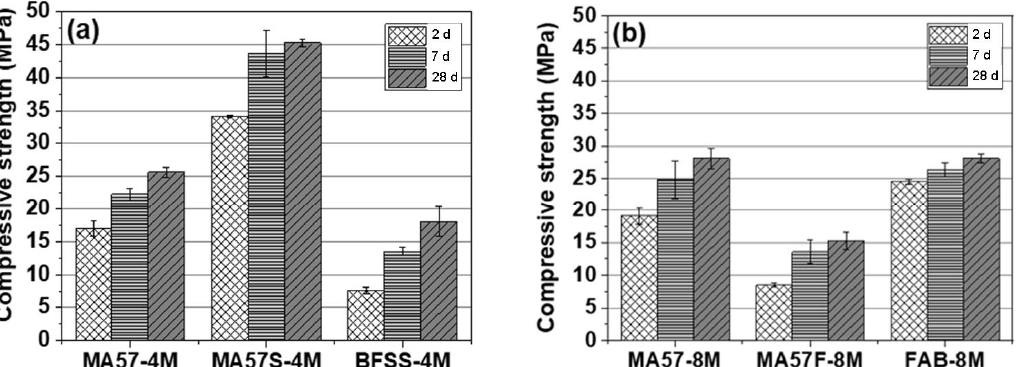
Figure 2. Compressive strength of samples tested at different stages: ( a ) 4 M NaOH activated pastes; ( b ) 8 M NaOH activated pastes. The mean values of six tests for each sample are reported. The standard deviations are represented by vertical bars.